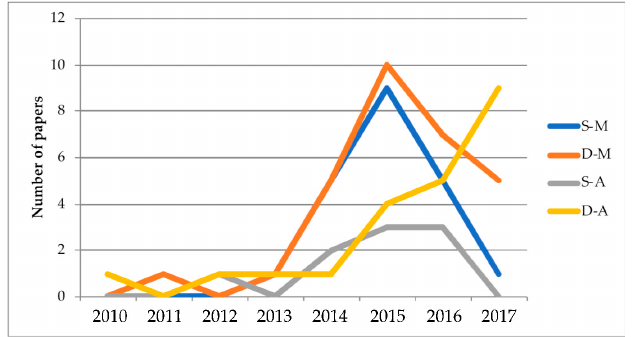
Figure 14. Evolution of the frequency of the used approach for the analyzed cost-optimal studies: simplified EP assessment with EEMs manual selection (S-M); dynamic simulation with manual EEMs selection (D-M); simplified EP assessment with automated EEMs selection (S-A); dynamic simulation with automated EEMs selection (D-A).